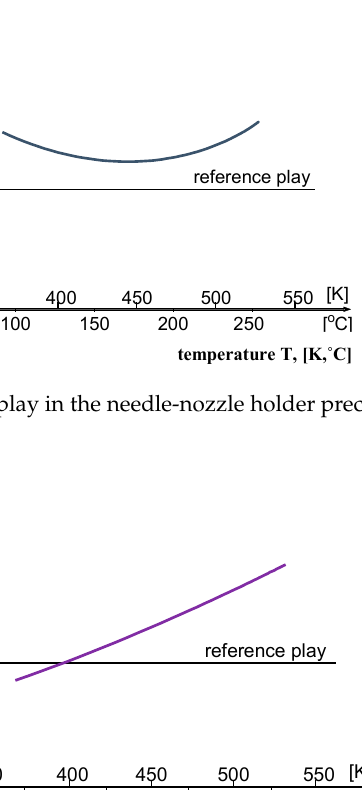
Figure 6. The play in the needle-nozzle holder precision pair of injector 2 as a function of operating temperature.